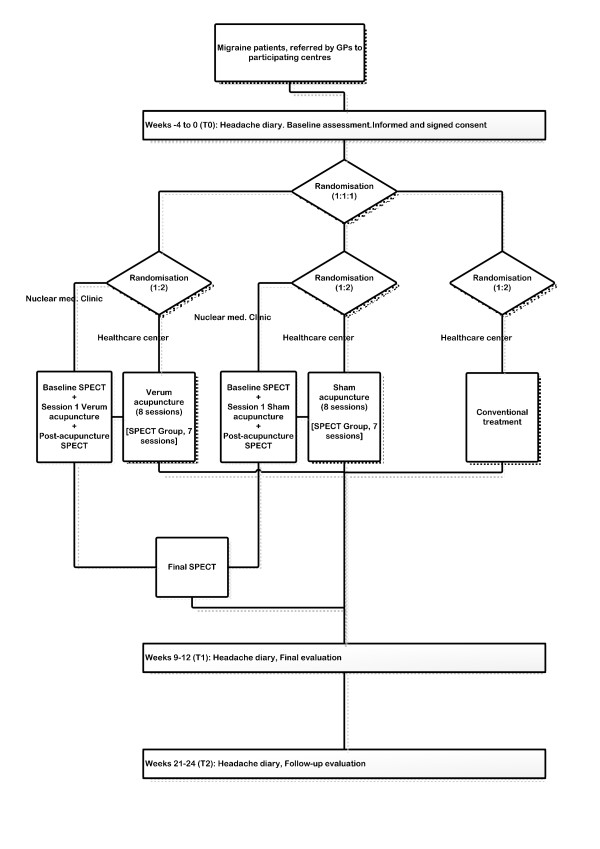
Trial work plan.